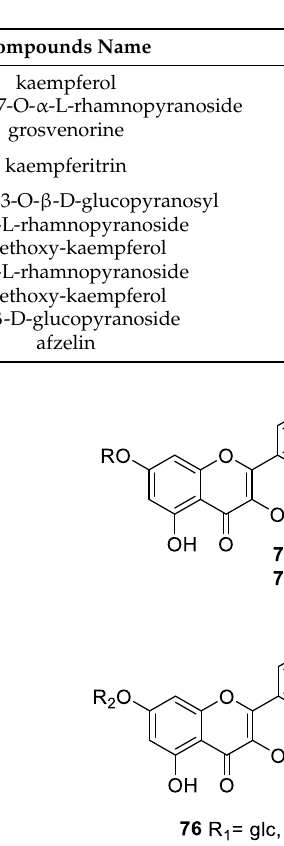
Table 2. Flavonoids isolated from S. grosvenorii .